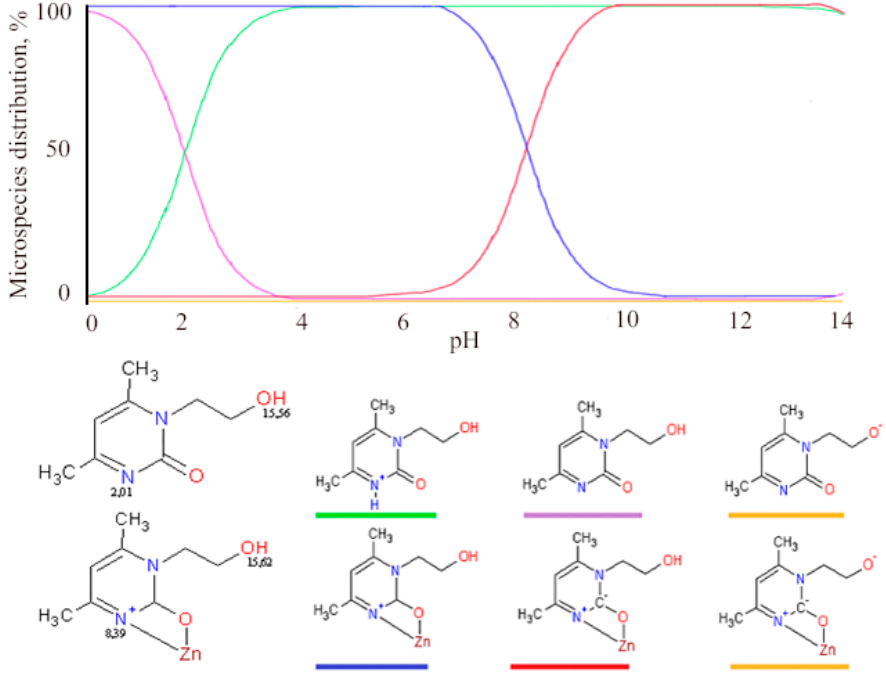
Figure 6. The dependence of microspecies distribution of xymedone and its zinc complexes (%) on pH.